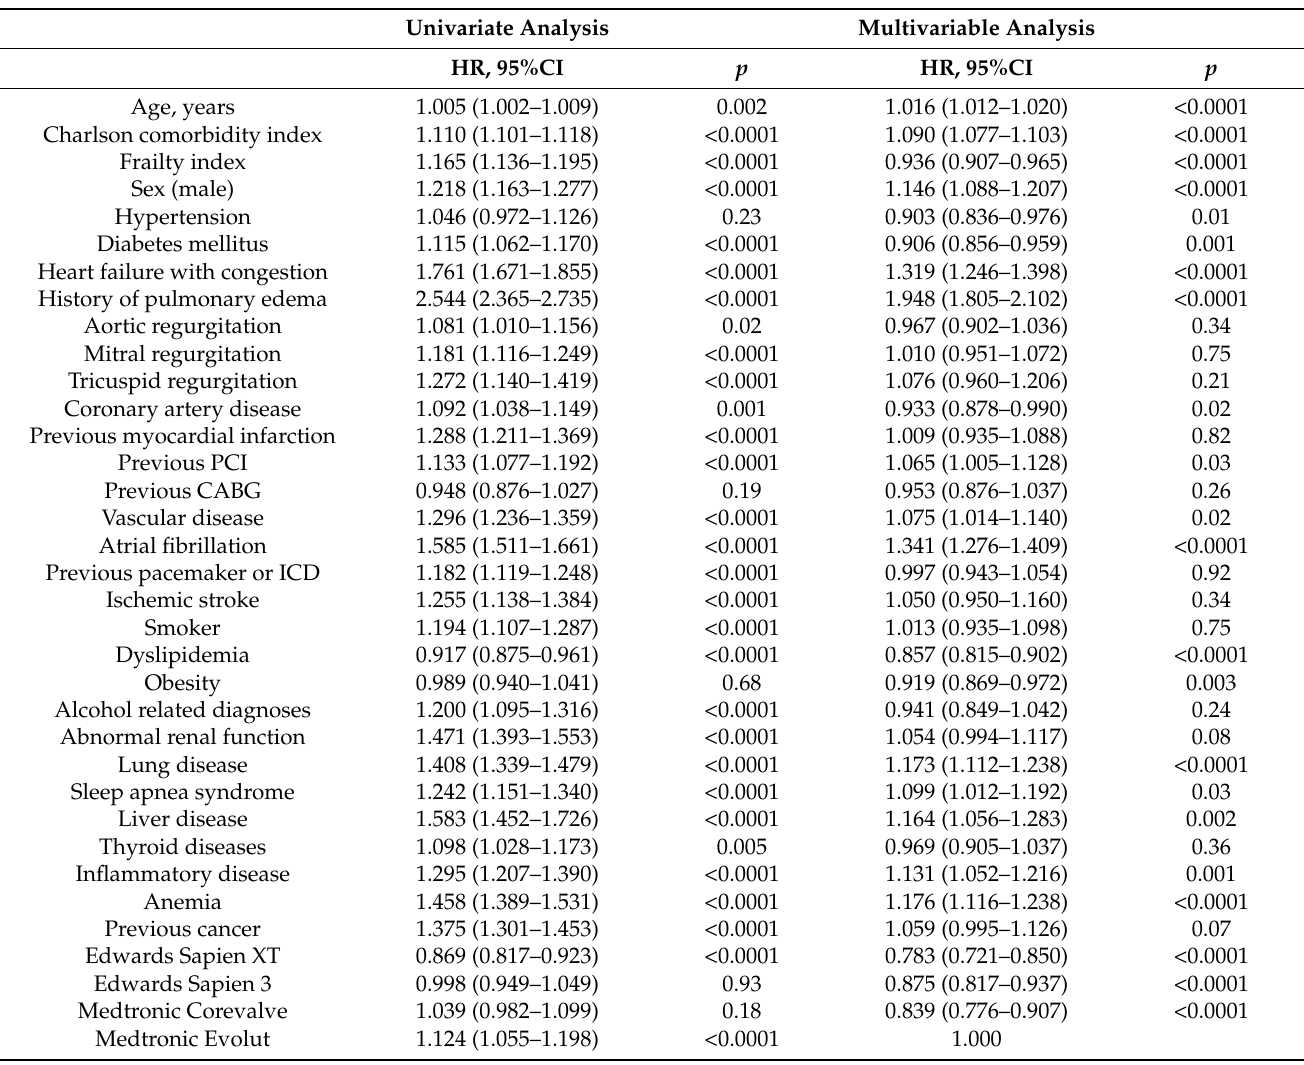
Table 2. Predictors of all-cause death in patients treated with TAVI.